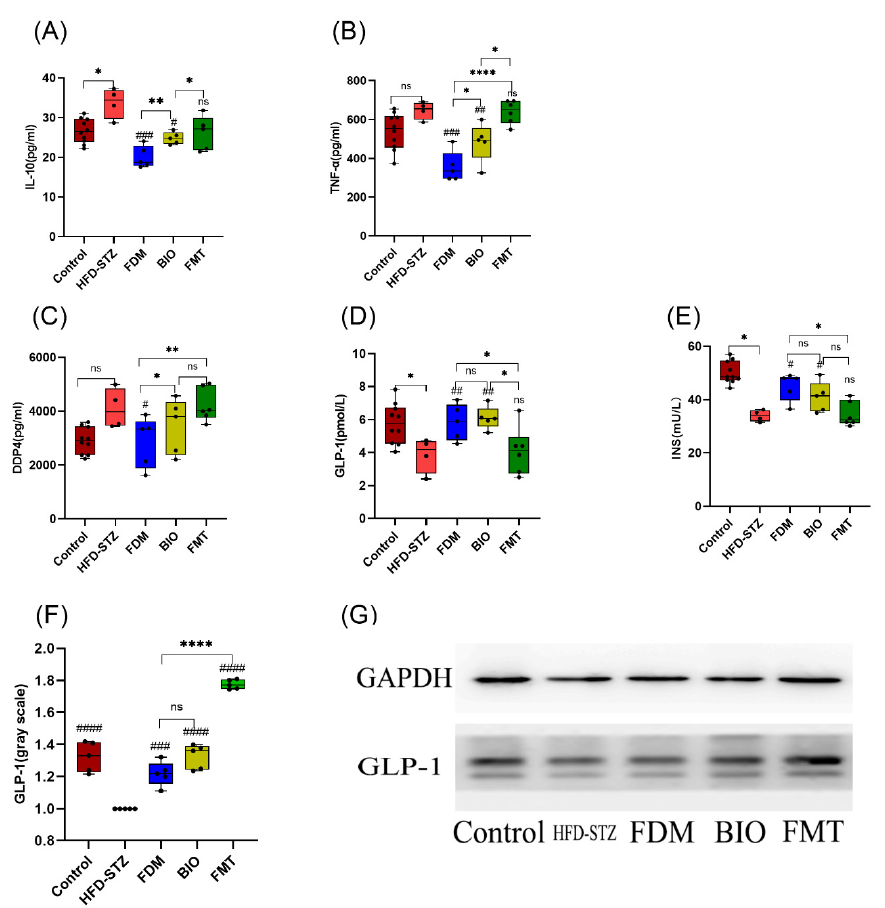
Figure 4. Effects of bacterial transplantation on levels of inflammatory factors. ( A , B ) Serum IL-10, and TNF- α levels in each group at 12th; the FDM group has the lowest levels of anti-inflammatory factor IL-10 and pro-inflammatory factors TNF- α . ( C – E ) Serum Dipeptidyl Peptidase-4 (DDP-4), glucagon-like peptide-1 (GLP-1) and insulin (INS) levels in each group at 12th; the FDM group has the highest levels of GLP-1 and INS. ( F ) Colonic GLP-1 western blotting gray value. ( G ) Western blotting of colonic GLP-1, which was secreted at the highest level in the FMT group. The number of mice in each group at the end of the experiment was as follows: control ( n = 10), HFD-STZ ( n = 4), FDM ( n = 5), BIO ( n = 5), and FMT ( n = 6). * ( p < 0.05), ** ( p < 0.01), **** ( p < 0.0001), and ns ( p > 0.05) represents the one-way ANOVA analysis with each group, # ( p < 0.05), ## ( p < 0.01), ### ( p < 0.001), and #### ( p < 0.0001) represents the one-way ANOVA analysis with the HFD-STZ group. The pancreas is the most vital organ for the regulation of blood glucose levels.